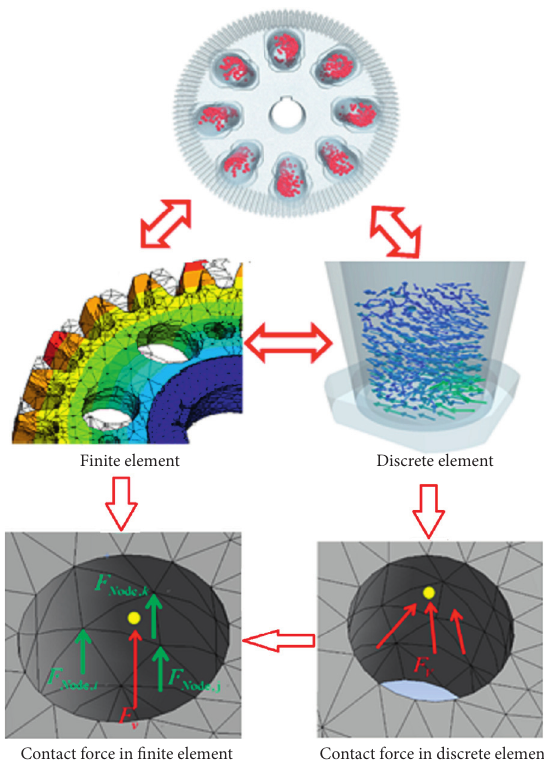
Figure 5: Discrete element and finite coupling method total flow of gear transmission.